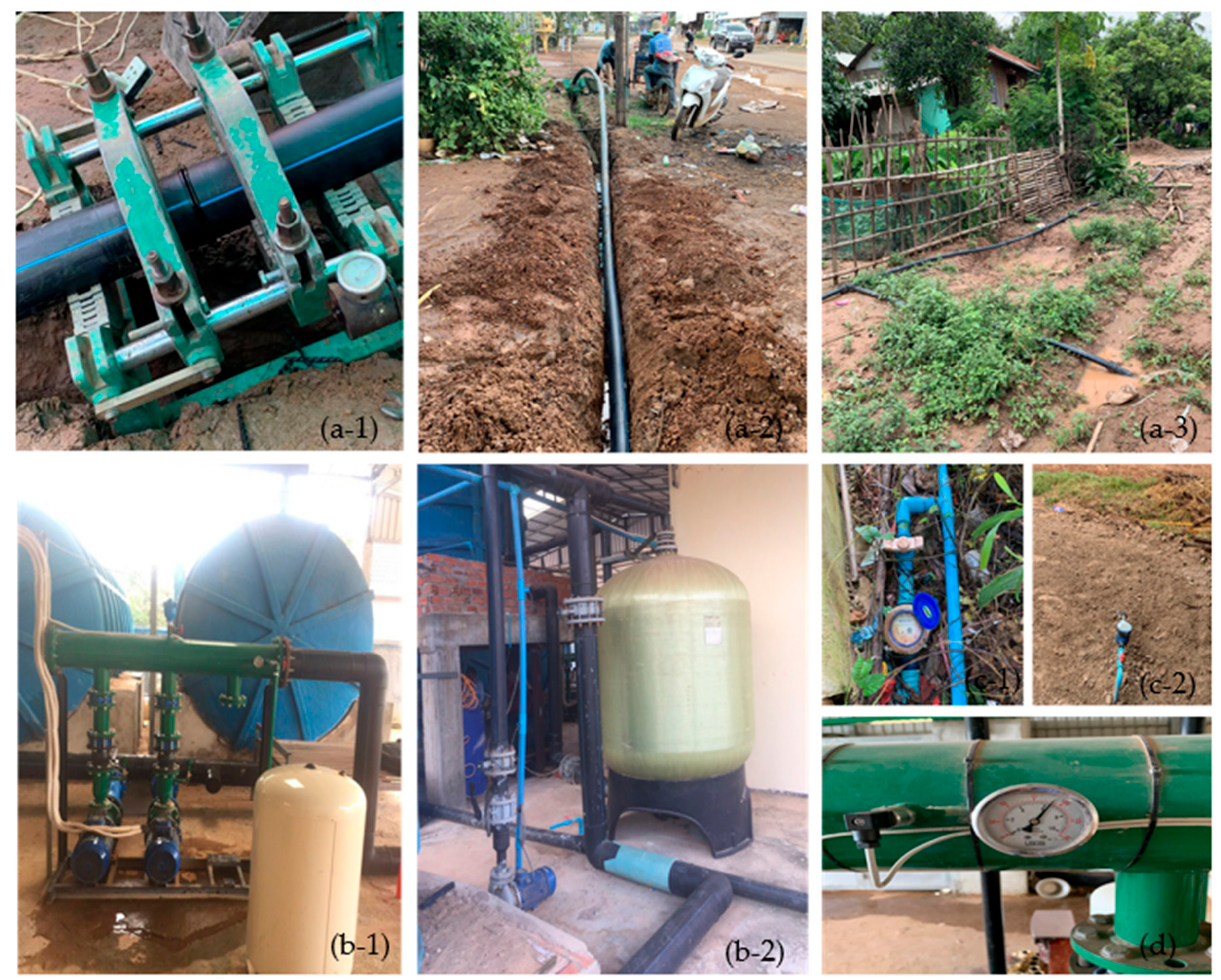
Figure A3. ( a-1 to a-3 ) Distribution pipe installation; ( b-1 and b-2 ) water purification installation; ( c-1 and c-2 ) water meter installation; and ( d ) water pressure meter.